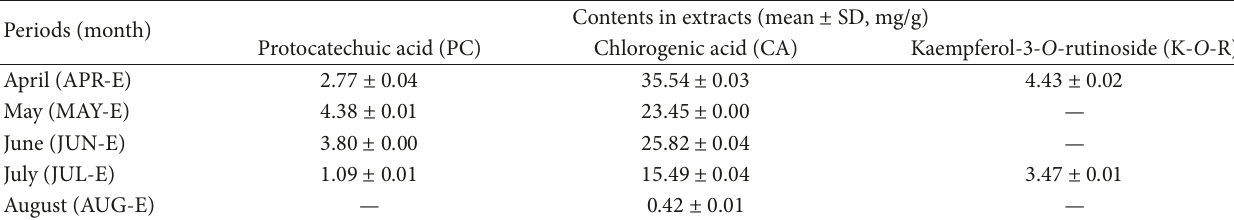
Table 4: Quantification of protocatechuic acid, chlorogenic acid, and kaempferol-3- O -rutinoside from Solidago virgaurea subsp. gigantea sample collection at different times.